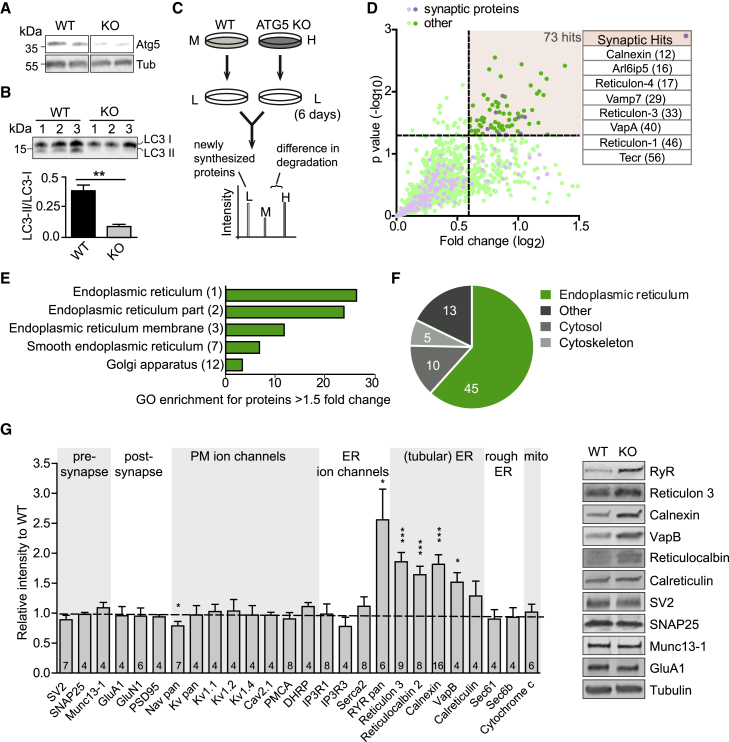
Decreased Degradation and Accumulation of ER Proteins in ATG5-iKO Neurons(A) Immunoblots showing ATG5 decrease in cell lysates from ATG5-iKO cerebellar granule neuron (CGN) cultures compared with control culture lysates.(B) Analysis of the LC3-II/LC3-I ratio in immunoblots of CGN lysates from WT and KO cultures. n = 3; unpaired t test.(C) Schematic showing the pulsed SILAC procedure to measure protein degradation. CGN cultures were grown for 2 weeks in medium containing heavy (H) or medium (M) variants of lysine and arginine. On day 14, the medium was replaced with normal medium containing unlabeled (L) amino acids. After 0 (t = 0) or 6 (t = 6) days, cells were harvested, mixed, and analyzed by MS analysis, resulting in a list of H/M ratios for each protein. The example shows an H-labeled peptide that is degraded at slower rates than the M-labeled peptide, resulting in H/M ratios greater than 1.(D) Four separate experiments were performed, in which 1,753 proteins were identified that exhibited H/M (KO/WT) ratios in at least 3 experiments (and 2 conditions, t = 0 and t = 6). Of the 1,753 proteins, 180 are considered to be synaptic proteins. To evaluate protein degradation over the course of 6 days, ratios at t = 6 are divided by t = 0 ratios, and fold changes are plotted. Of 1,753 proteins, 73 showed a significant increase in average H/M ratios over the period of 6 days (defined as log2fold change > 0.6 and p < 0.05, dotted lines); that is, they exhibited slower degradation rates in ATG5-iKO neurons. The table shows the protein hits considered to be synaptic (the rank of hit is shown in brackets).(E) Gene Ontology analysis indicates that most of the proteins that show slower degradation rates in KO neurons (fold change > 1.5) are localized to the ER (the rank of overrepresented GO Cellular component is shown in brackets).(F) Main subcellular localization of the 73 hit proteins (UniProtGO Annotation Database).(G) Immunoblot analysis and representative examples of lysates from WT and KO CGNs in culture, using antibodies against the indicated proteins. Bars show the protein level change of the indicated proteins normalized to the housekeeping gene tubulin. The mean values for the controls are set to 1. n, indicated in bars; one-sample t test.All data represent mean ± SEM. ∗p < 0.05, ∗∗p < 0.01, ∗∗∗p < 0.001.